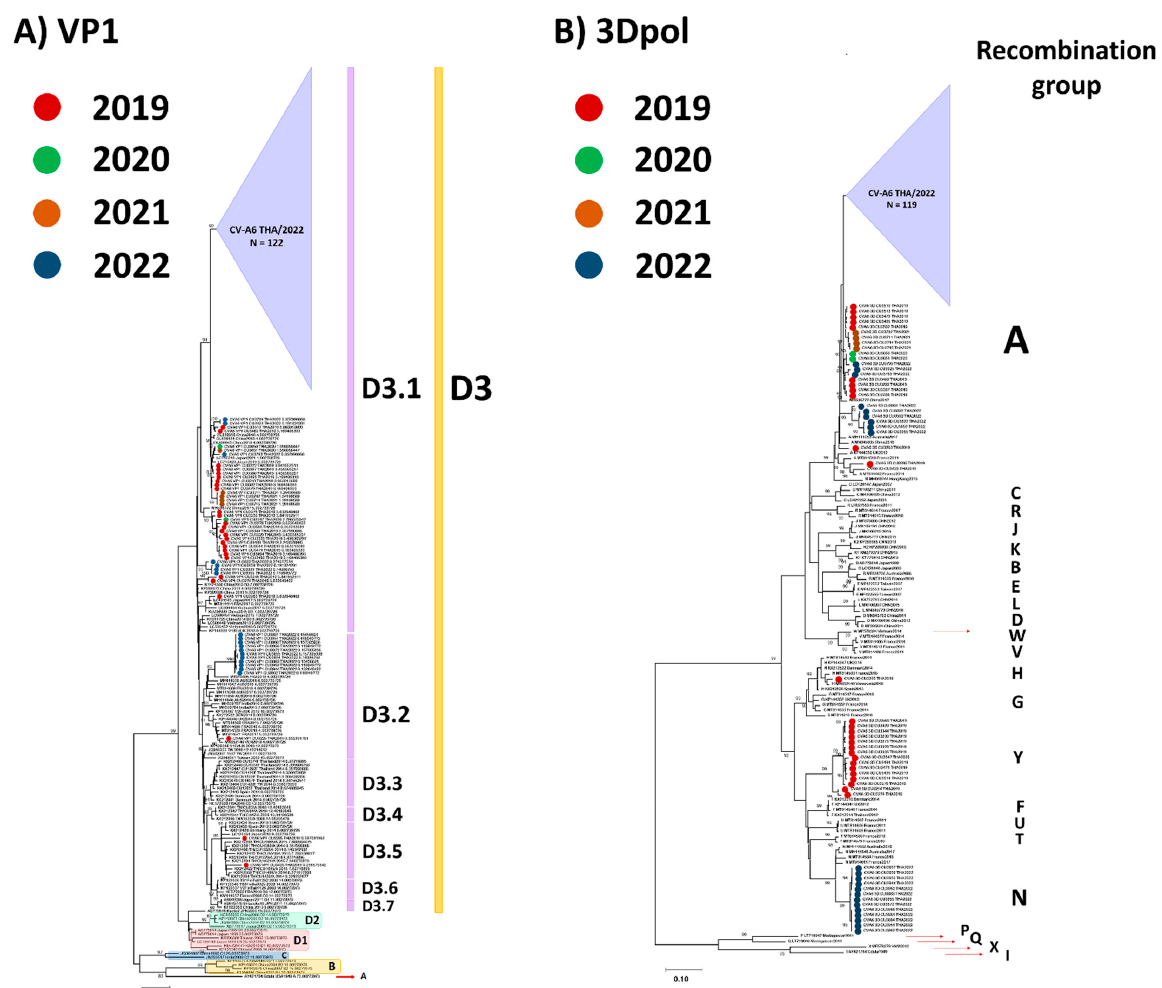
Figure 2. Phylogenetic comparisons of sequences from partial VP1 and 3Dpol. Phylogenetic com- parisons of sequences from ( A ) partial VP1 (nt positions 2630–3286, 657 bp) and ( B ) partial 3Dpol (nt positions 6188–7388, 1200 bp) using samples and sequences of other coxsackievirus (CV)-A6 variants obtained from GenBank. Maximum-likelihood trees were reconstructed using 1000 bootstrap re-samples to demonstrate the robustness of groupings; values ≥ 70% are shown.